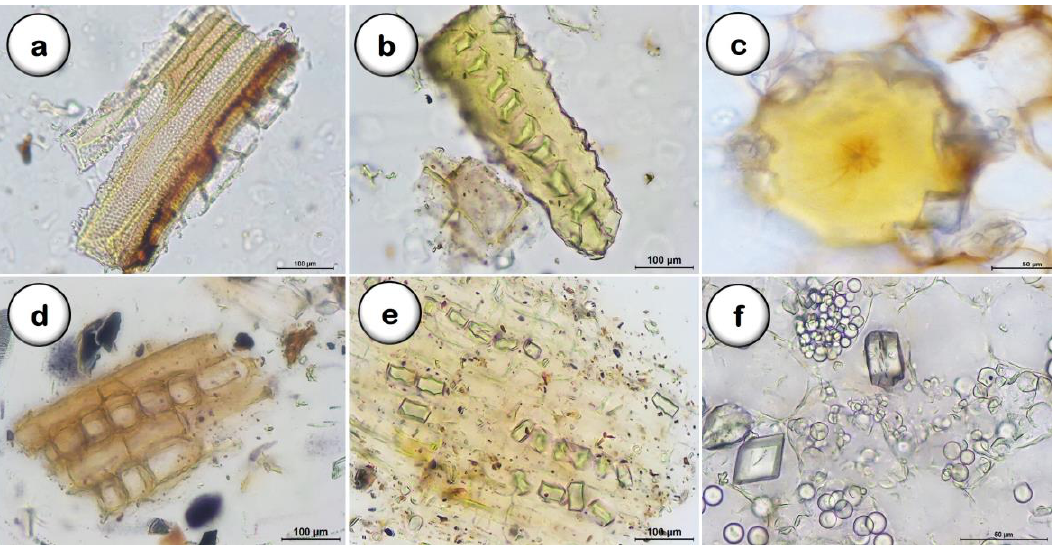
Figure 5. D. villosa root, powder. ( a ): Xylem vessels associated with fibers and medullary rays; ( b ): Libriform fibers; ( c ): Brachysclereid with a ring of prismatic calcium oxalate crystals; ( d ): uniseriate medullary rays; ( e , f ): Starch grains and prismatic calcium oxalate crystals. Bars: a , b , d and e = 100 µm; c and f = 50 µm.